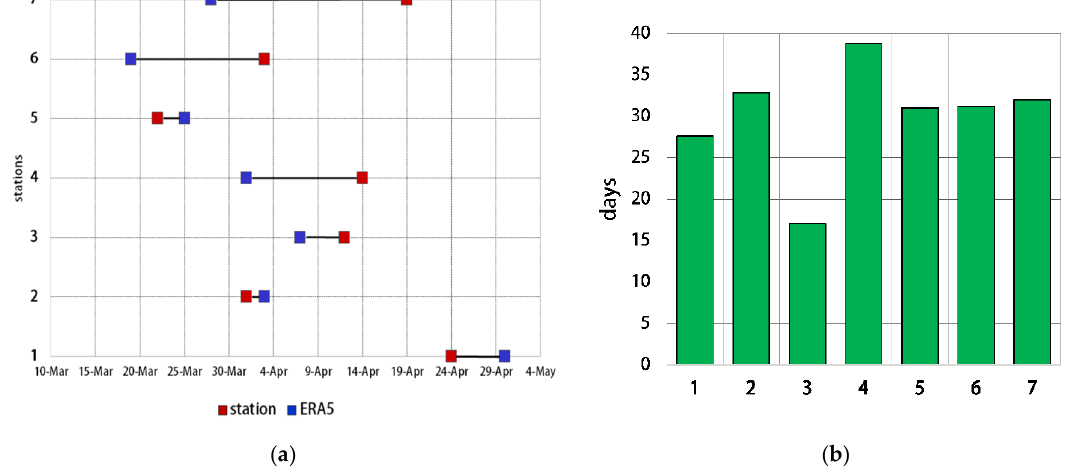
Figure 12. Mean date of maximum snow height at the end of cold season ( a ) and RMSE ( b ) for seven stations and the nearest grid points of ERA5 reanalysis.